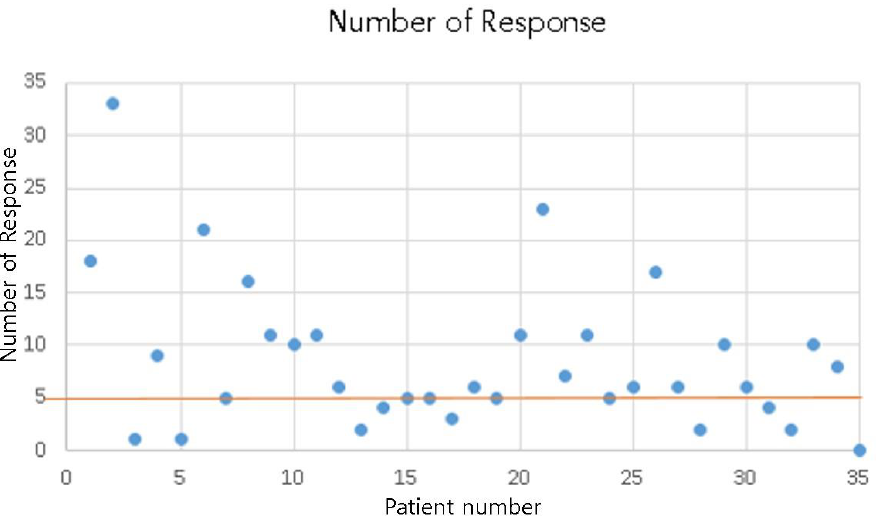
Figure 7. The number of side effect responses.